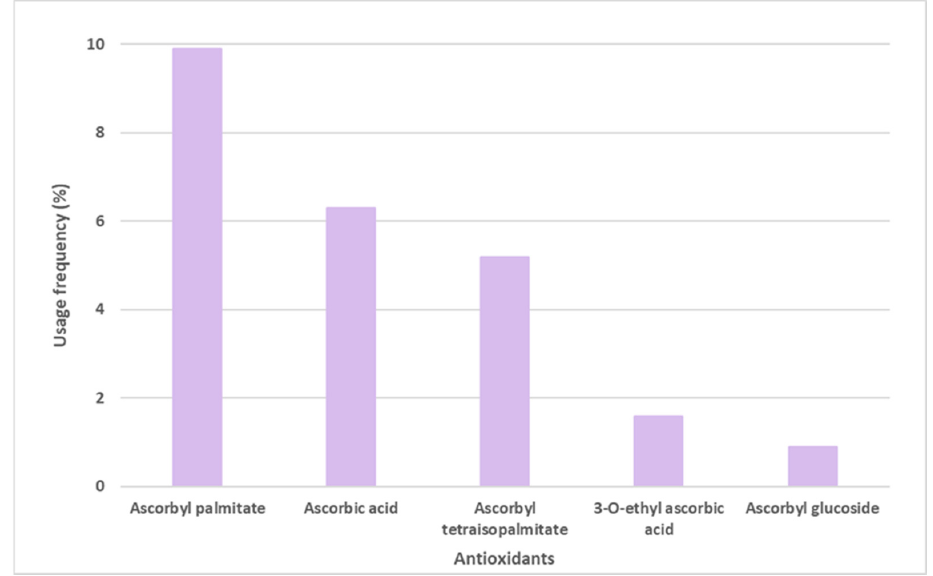
Figure 5. Usage frequency of vitamin C (ascorbic acid) and its derivatives in sunscreens.